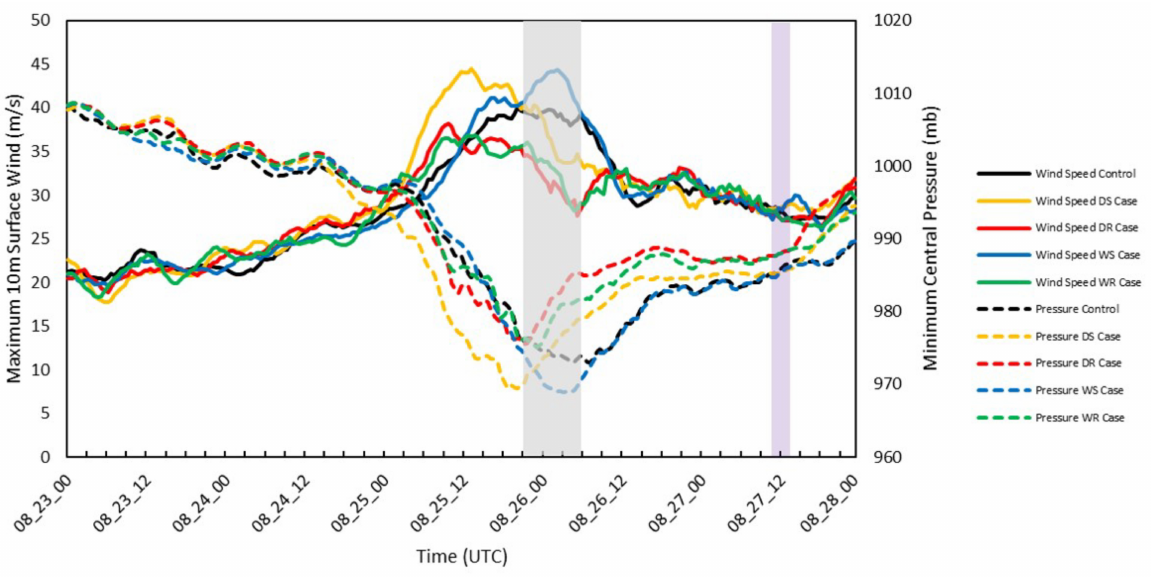
Figure 4. Time series of minimum central pressure (mb) and maximum wind speed (m s − 1 ) for all simulations with grey box spanning the Florida landfall times and purple box spanning South Carolina landfall